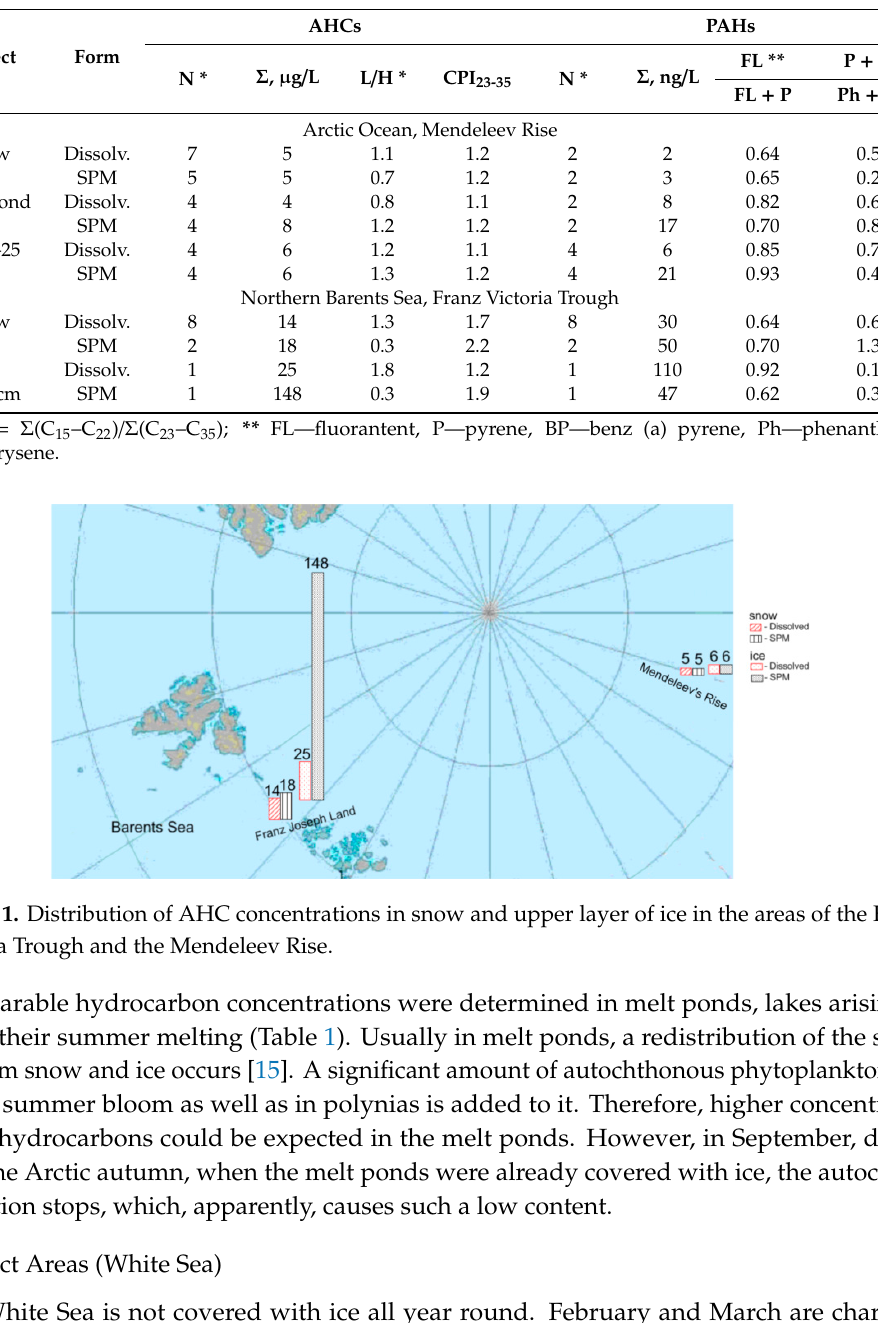
Table 1. The content and composition of aliphatic HCs and PAHs in the snow and the upper part of the ice.